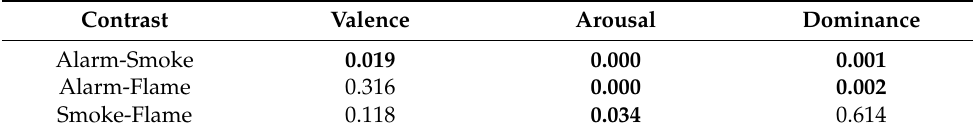
Table 6. p -values of SAM